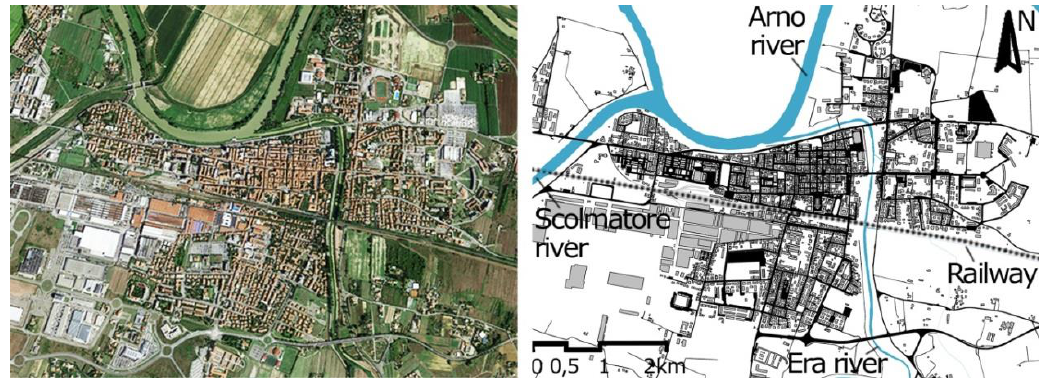
Figure 3. Aerial view of Pontedera ( left ) and schematic representation of its roads ( right ).